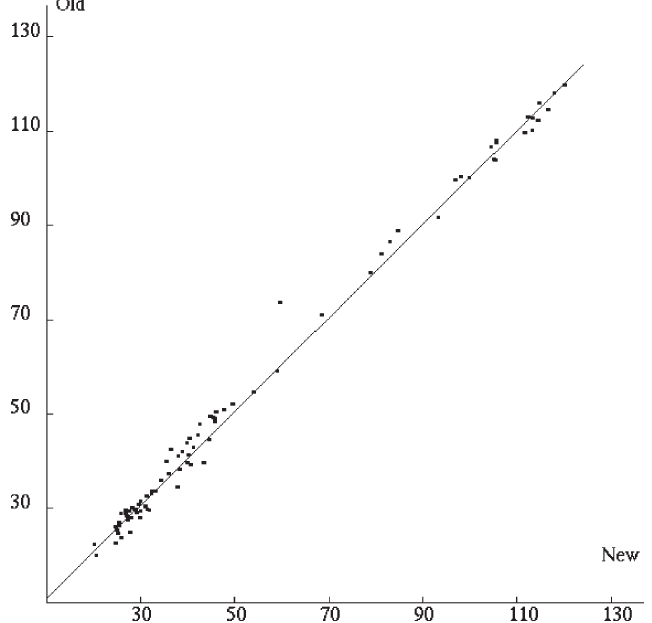
Fig. 6. Comparison of DNA measurements on isolated nuclei using the old (2 1 / 2 D) and new 3D segmentation